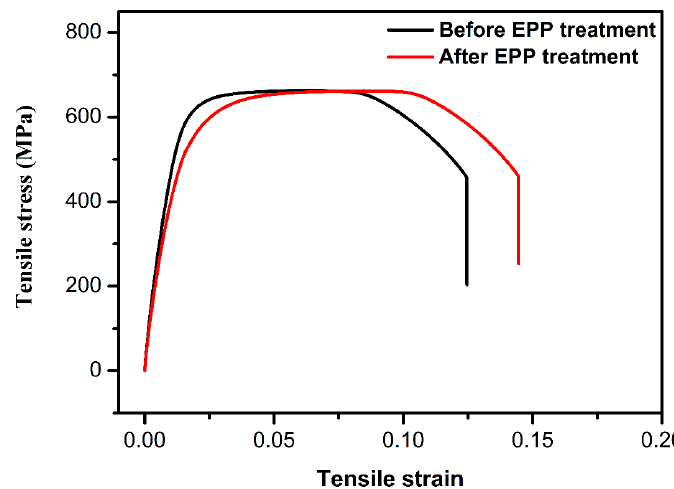
Figure 6. Stress-strain curve of Q195 carbon structural steel. (Before EPP: black curve ; After 25 s EPP treatment: red curve ).